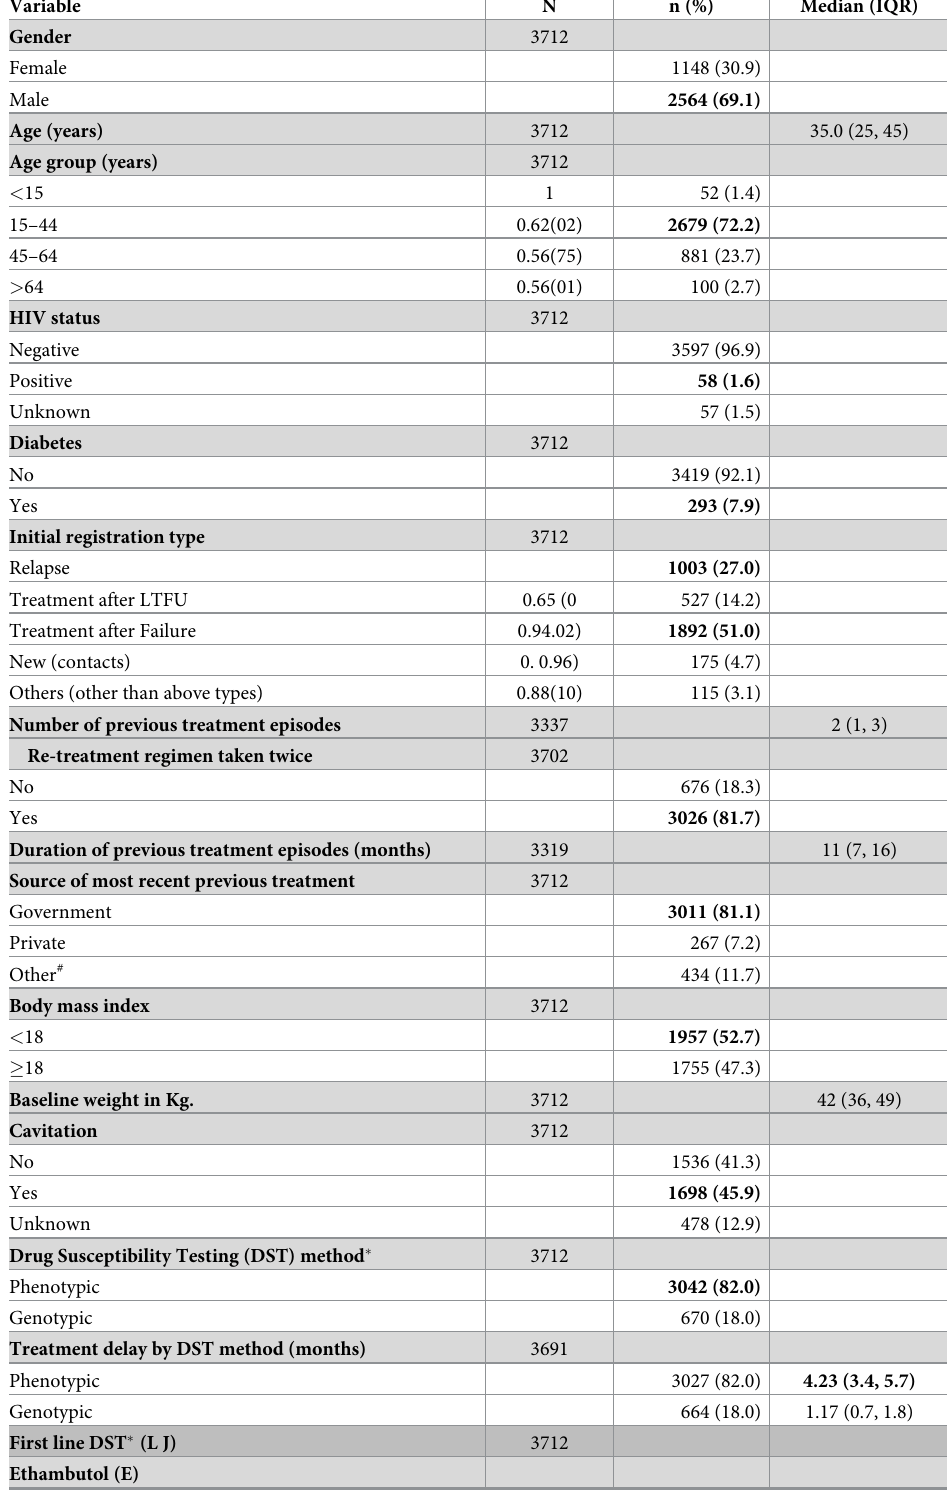
Table 1. Characteristics of MDR-TB